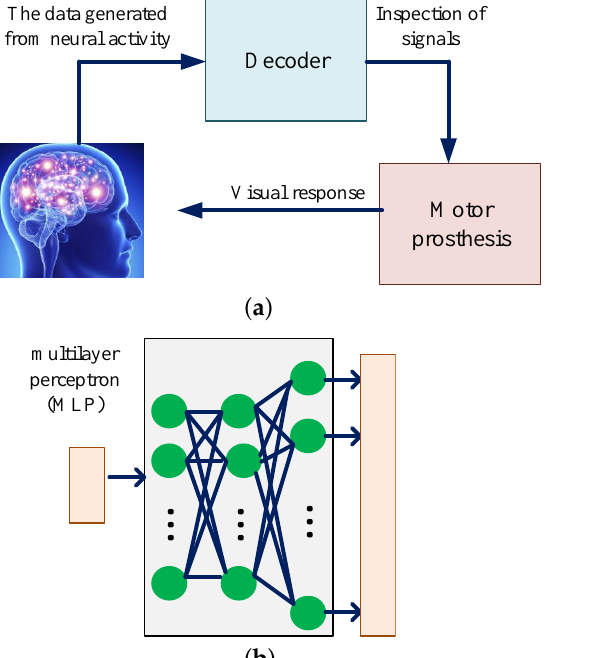
Figure 19. ( a ) BMI system and neural encoder ( top ); ( b ) multilayer perceptron (MLP) architecture ( bottom ).